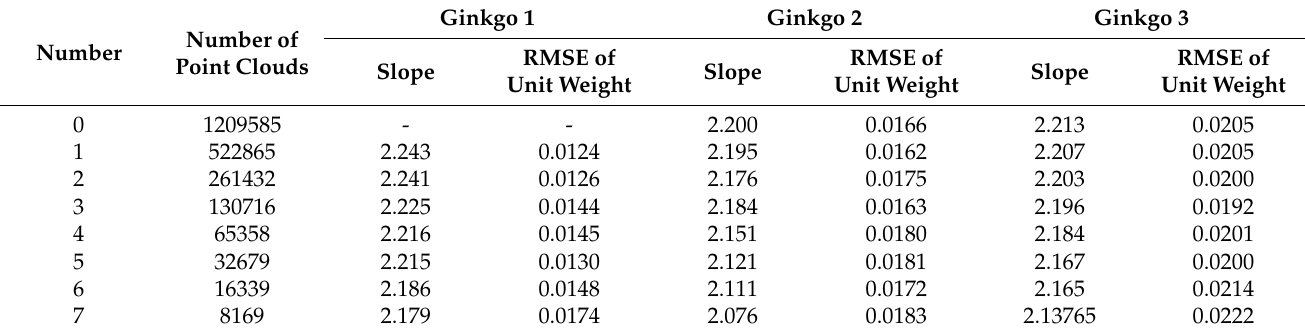
Table 3. Fractal dimension of ginkgo tree 1 with different number and density of point